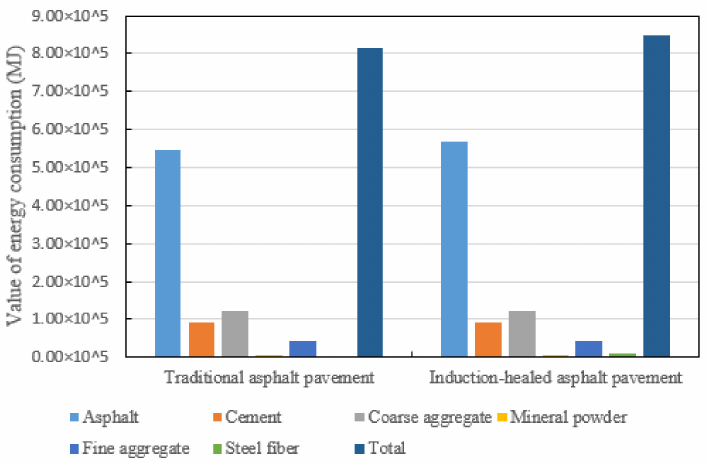
Figure 3. Fluctuation chart of energy consumption of the two asphalt pavements in the material manufacturing